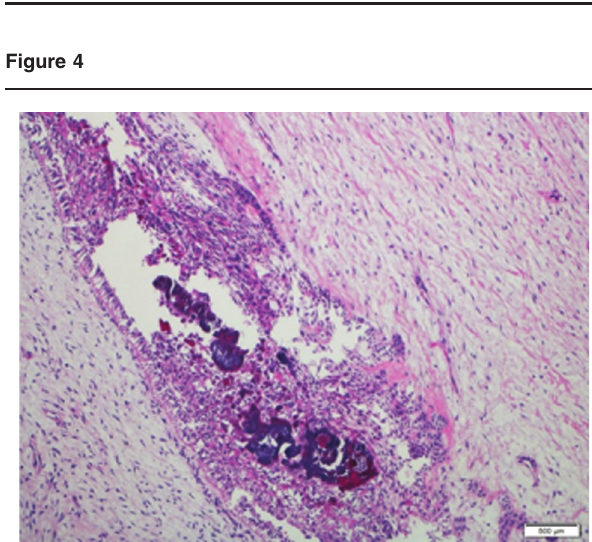
The odontogenic epithelium exhibits peripheral columnar cell pali- sade and central reticulum-like cells. Areas of calcification are noted in association with the epithelium. The tooth within the